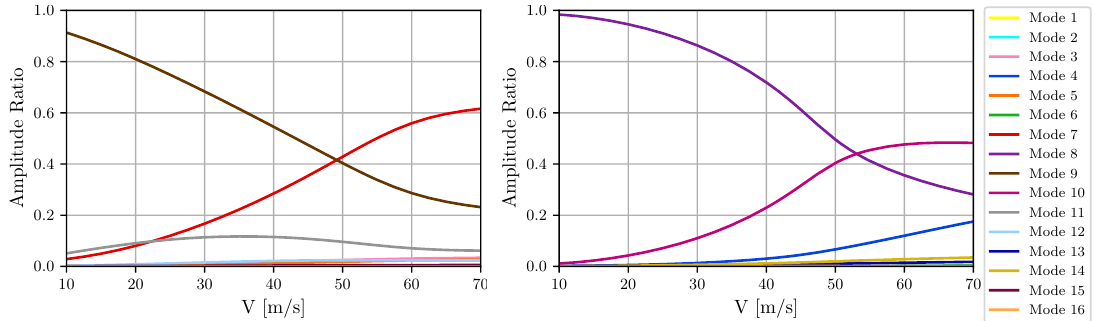
( a ) Symmetric flutter mechanism (aeroelastic ( b ) Antisymmetric flutter mechanism (aeroelastic degree of degree of freedom 9). freedom 8). Figure 18. Velocity trends of the absolute values of the modal amplitude ratios representing the participation of the strucural